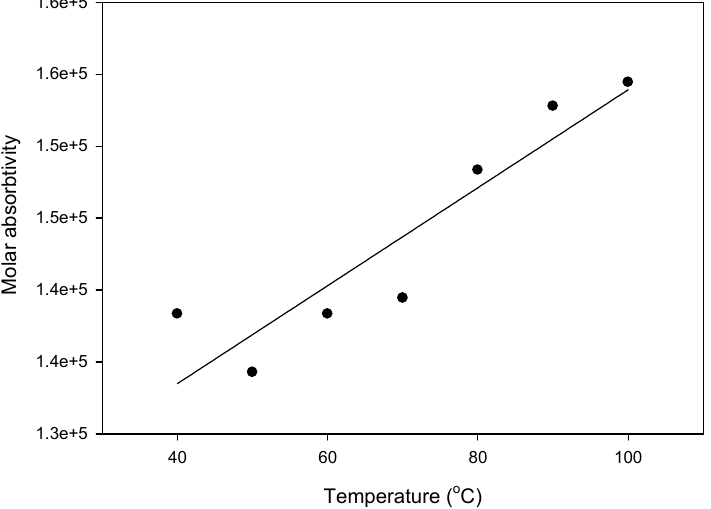
Figure 7. UV absorption spectrum of the I6/A supramolecular complex with a heating range from 40 to 100 °C ( a ) in the DMF solvent and ( b ) in the toluene solvent.